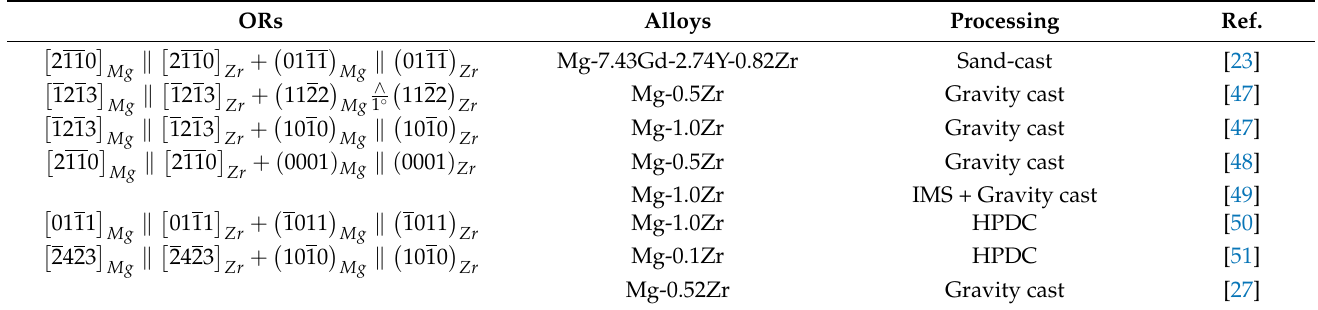
Table 3. Reported ORs between Mg and Zr in grain-refined Mg alloys 1 .